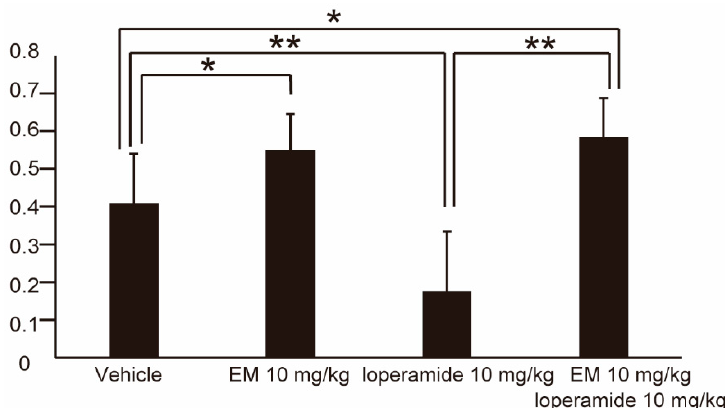
Figure 6. Gastric emptying of human MLNR Tg mice following peripheral (intraperitoneal) administration of vehicle only ( n = 14), EM only ( n = 10), loperamide only ( n = 8), or EM + loperamide ( n = 6). Values represent the mean ± SD for the indicated number of animals. * p < 0.05, ** p < 0.01 (One-way ANOVA with Tukey post-hoc test).